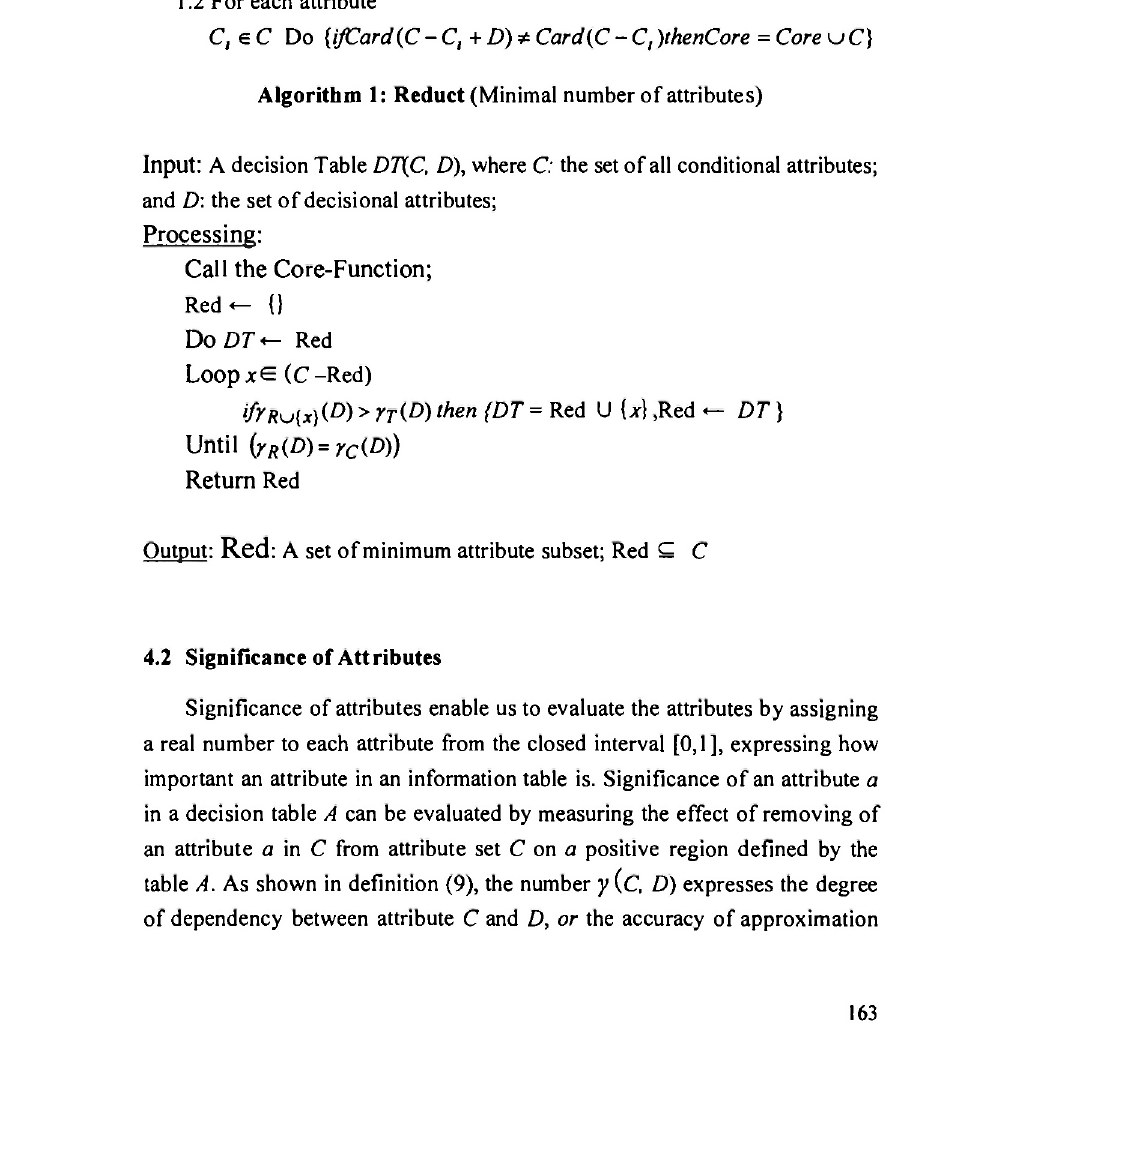
Algorithm 1: Reduct (Minimal number of